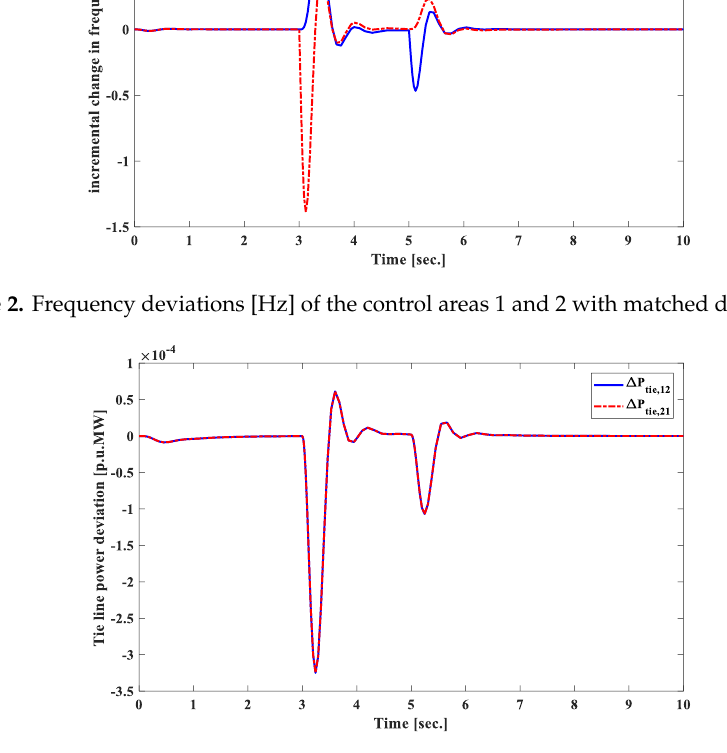
Figure 4. Control input [p.u.] of two control areas with matched disturbances.